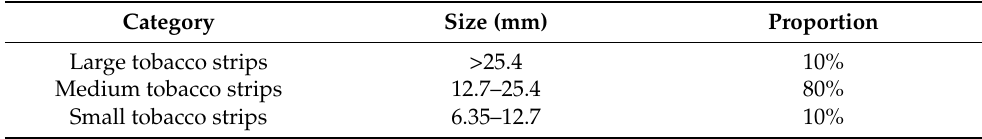
Table 1. Different sizes and proportions of tobacco